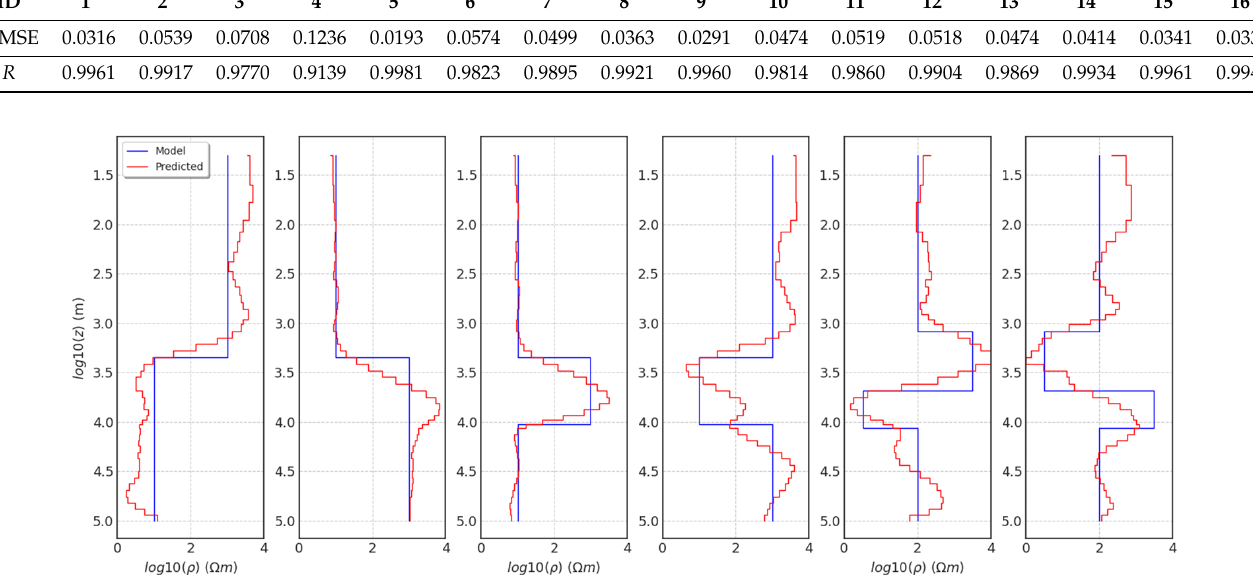
Figure 5. Comparison of predicted resistivity with CNN inversion and true layered resistivity models.